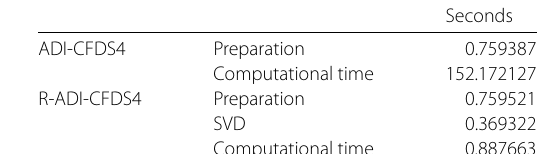
Table 18 The consuming time of two schemes for SP 4 at t = 4, with h x = h y = 0.02 π , τ = 0.02